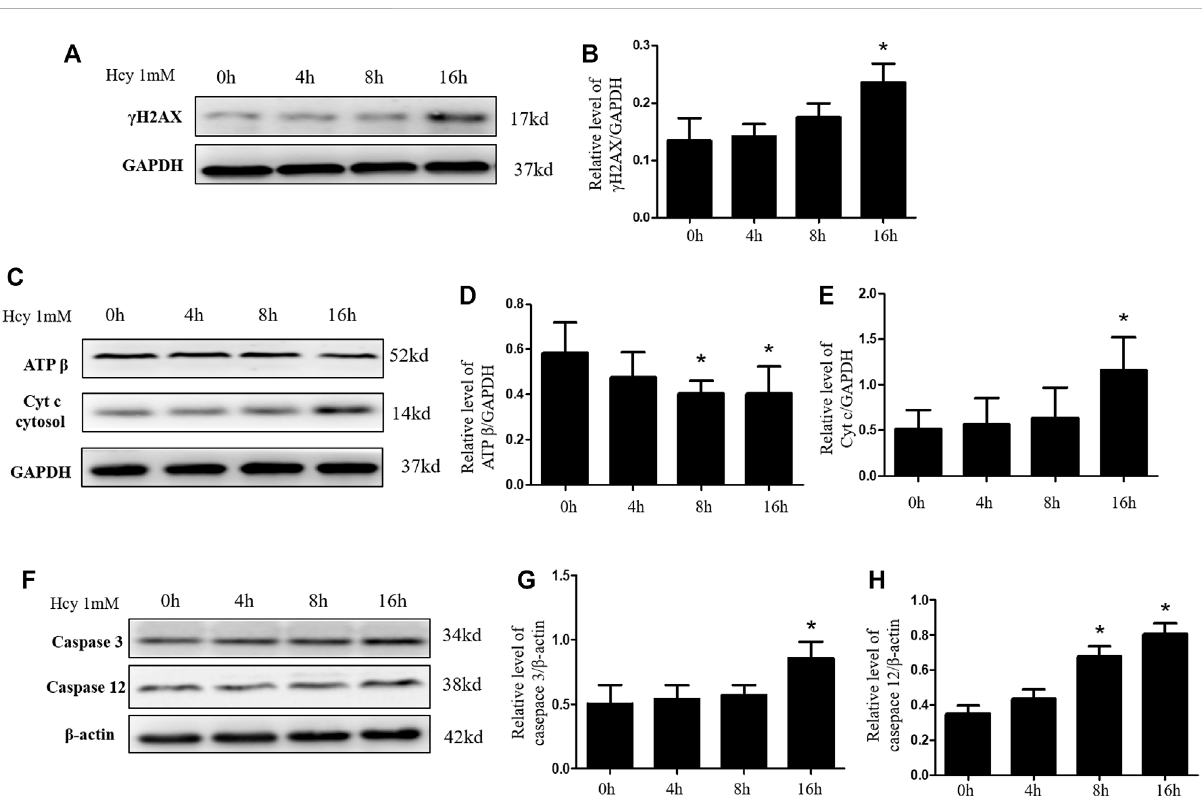
FIGURE 4 Hyperhomocysteinemia aggravates DNA damage and mitochondrial damage in vitro . (A , C , F) Representative western blots show the levels of γ H2AX, ATP β , Cyt C, Caspase 3, and Caspase 12 in NRK-52E cells after homocysteine stimulation. (B , D , E , G , H) Relative levels of: (B) γ H2AX, (D) ATP β , (E) Cyt C, (G) caspase 3, and (H) caspase 12. Data expressed as mean ± SD, n = 3 per group. * p < 0.05 versus 0